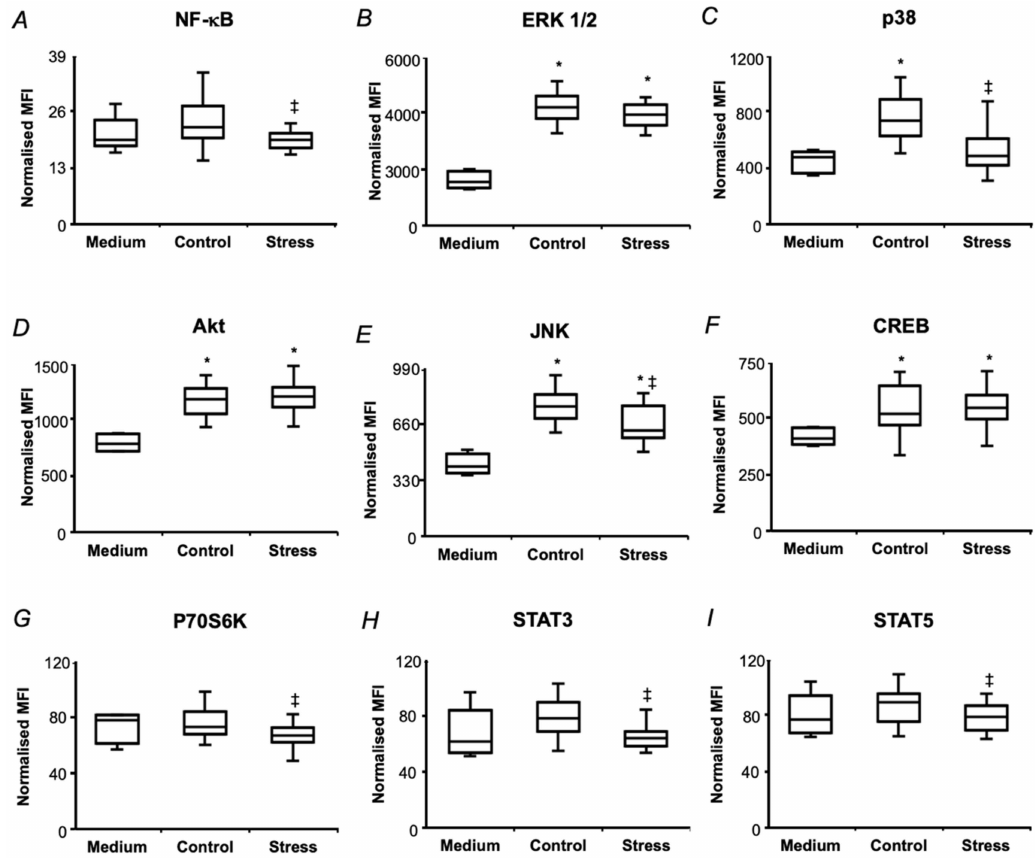
Figure 8. The e ff ects of pea seed protein hydrolyzates on the MAPK / ERK, PI3K / Akt / mTOR and JAK / STAT signaling pathways in SH-SY5Y human neuroblastoma cells. The total protein fraction was isolated from pea ( Pisum sativum L., cultivar SGE) seeds after a two-day exposure of the plants (at the seed maturation step) to the aqueous medium with and without addition of 2.5% ( w / v ) PEG 8000 (defined as Stress and Control, respectively) and subjected to exhaustive enzymatic hydrolysis. The levels of phosphorylated NF- κ B ( A ), ERK 1 / 2 ( B ), p38 ( C ), Akt ( D ), JNK I ( E ), CREB ( F ), p70S6K ( G ), STAT3 ( H ), STAT5 ( I ) were determined in SH-SY5Y cell lyzates by Luminex ® xMAP ® technology after 3 h of incubation with protein hydrolysates (0.5 mg / mL), supplemented to the culture medium, and normalized to total protein content. The data are presented as median, inter-quartile range, minimal and maximal values, and were analyzed by one-way ANOVA with Tukey’s multiple comparisons test ( n = 5, five technical replicates per biological one). Statistically significant di ff erences ( p < 0.05) in comparison to the medium-treated cells (Medium) and to the cells, treated with protein hydrolyzates, obtained from the seeds of control plants (Control) are denoted as * and ‡ , respectively. MFI, median fluorescent